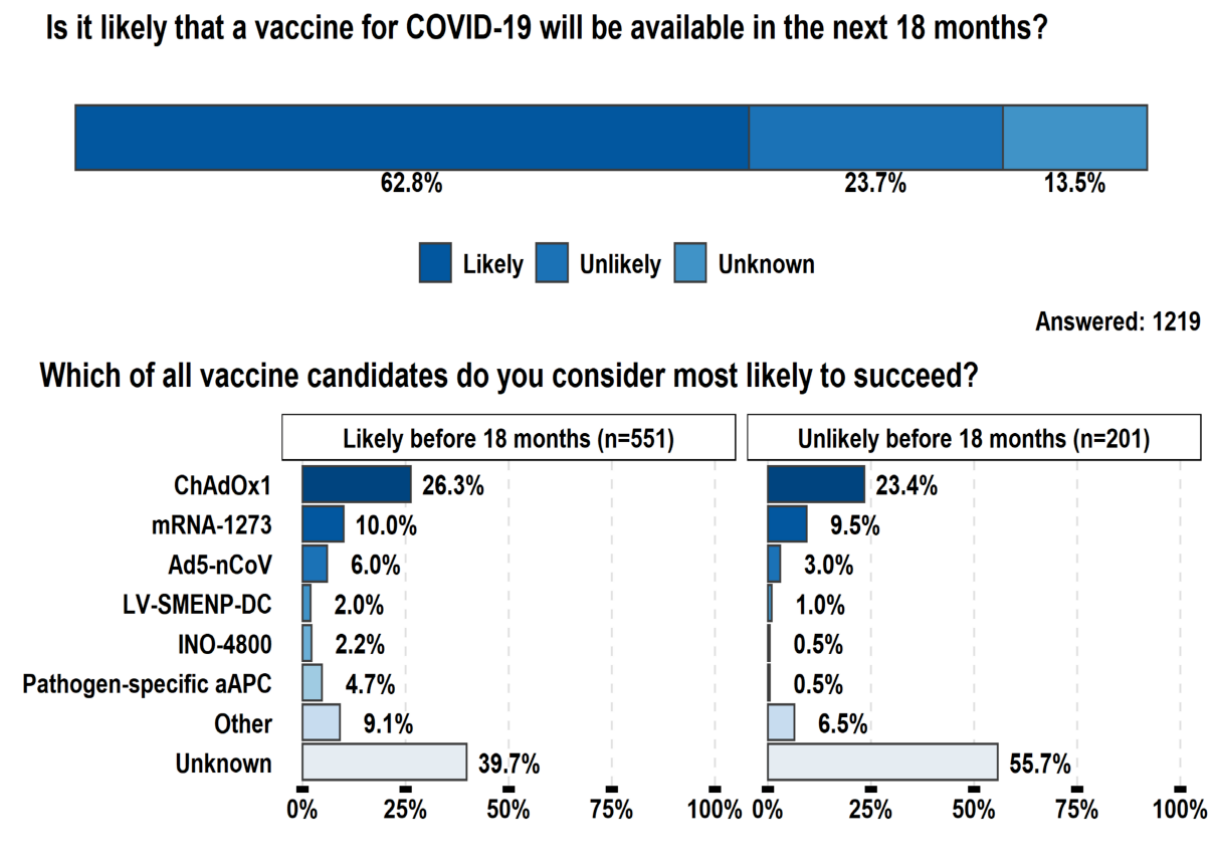
Figure 3. Survey respondents’ expectations regarding whether a vaccine for COVID-19 will be available in the next 18 months, and their choices of the most promising vaccine